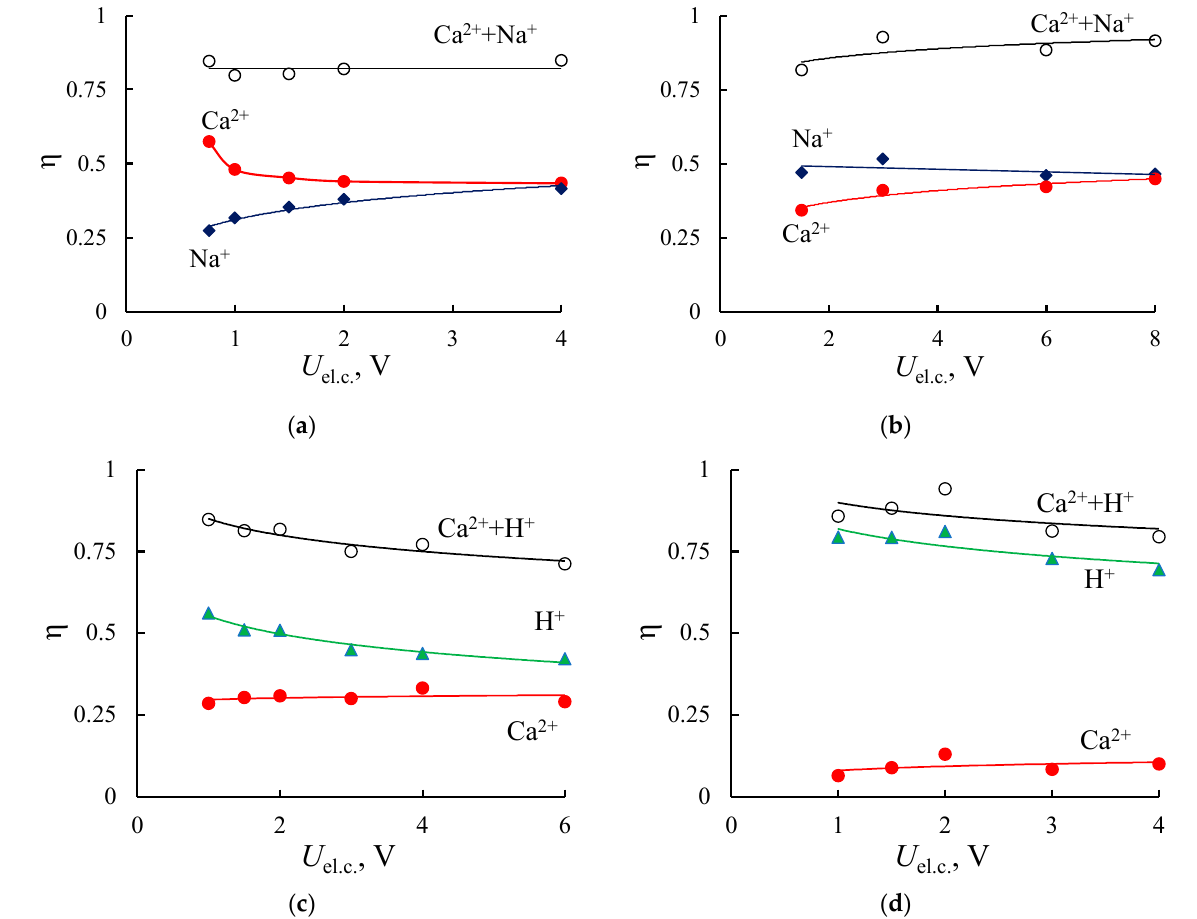
Figure 12. Current efficiency for the elecrodialysis processing of NaCl + CaCl 2 ( a , b ) and HCl + CaCl 2 ( c , d ) solutions with the initial MF-4SK ( a , c ) and composite MF-4SK/PANI ( b , d ) membranes.